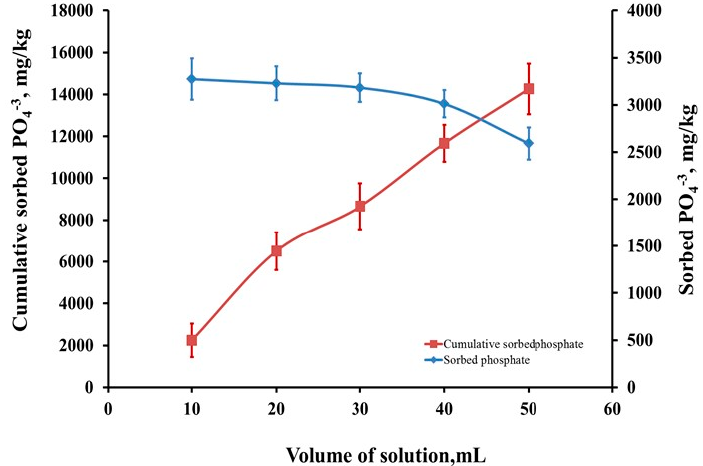
Figure 8. Sorbed and cumulative sorbed amounts of phosphate by nSD-KF in a packed-column study (5 g coarse sand; 5 g fine sand; 0.5 g nSD-KF; flow rate = 0.50 mL/min; PO 4 − 3 = 166 mg/L; volume = 50